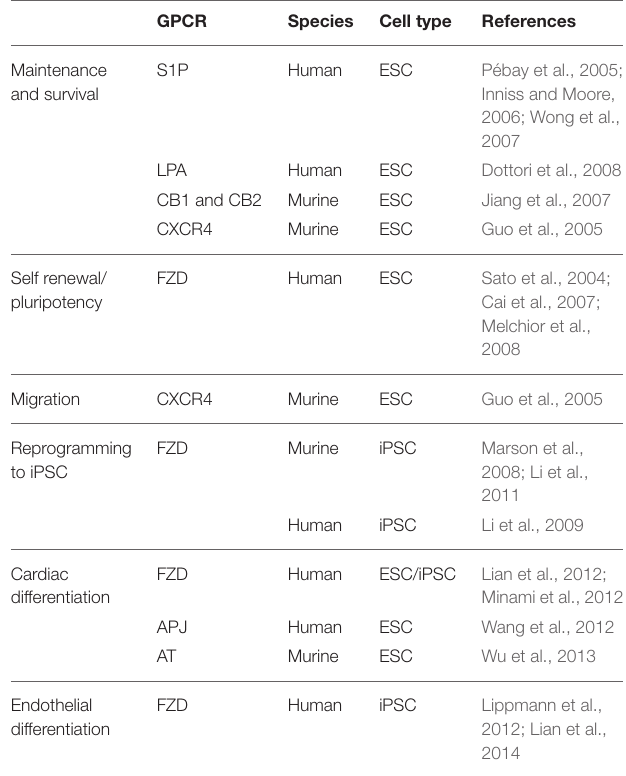
TABLE 1 | GPCRs with roles in hESC/hiPSC and differentiation to cardiovascular